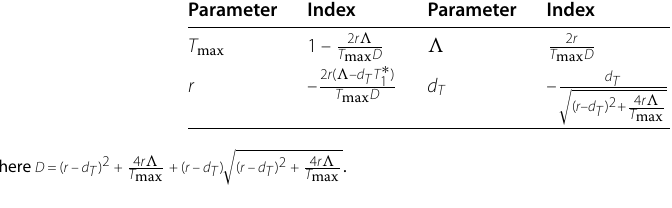
Table 4 Sensitivity indices for chronic healthy T-cell population T ∗ Parameter Index